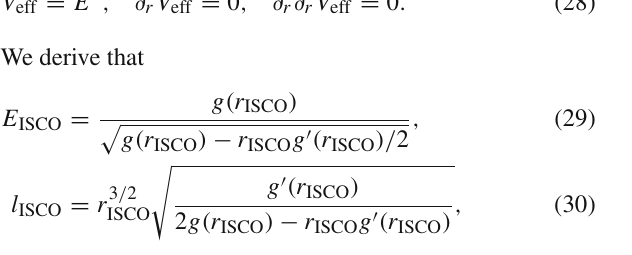
Q in the DMPR brane-world black holes for this case, the values of E ISCO , l ISCO and r ISCO are larger than the ones in the Schwarzschild black holes.